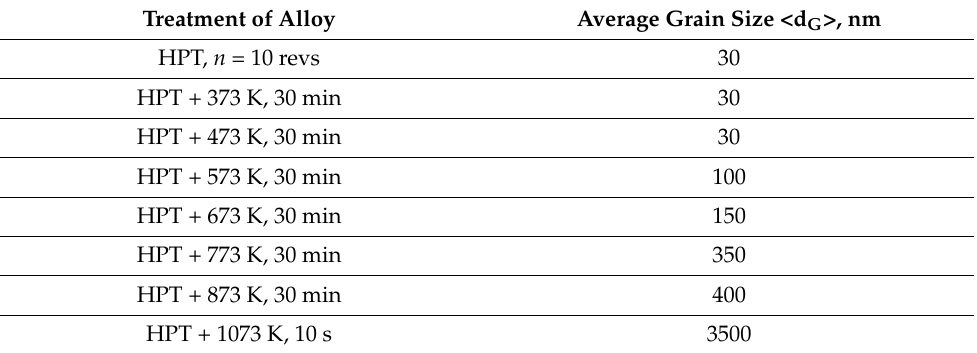
Figure 16. SEM images of the microstructure of the Cu-14Al-3Ni alloy after the HPT of 10 revs and annealing at 1073 K for 10 s at ( a , b ) different magnifications. Table 3. Average size of grains of the Cu-14Al-3Ni alloy subjected to HPT of 10 revs and to different